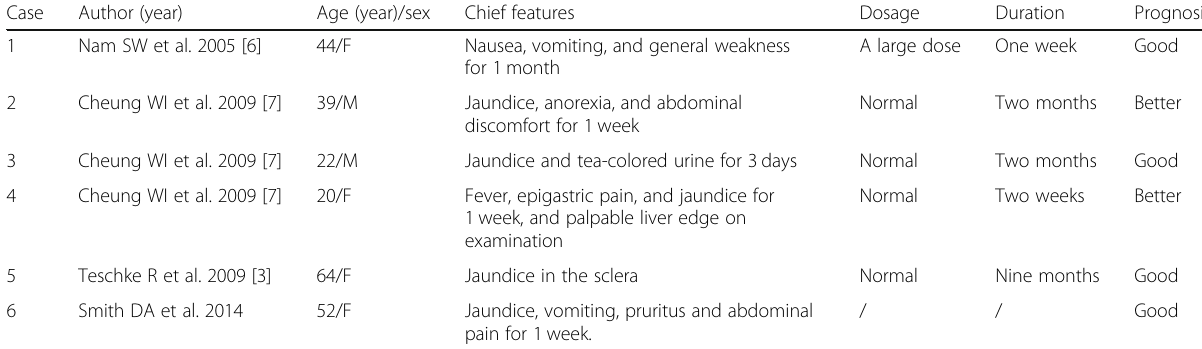
Table 1 Comparison of cases of liver injury caused by Psoraleae Fructusinthe literature